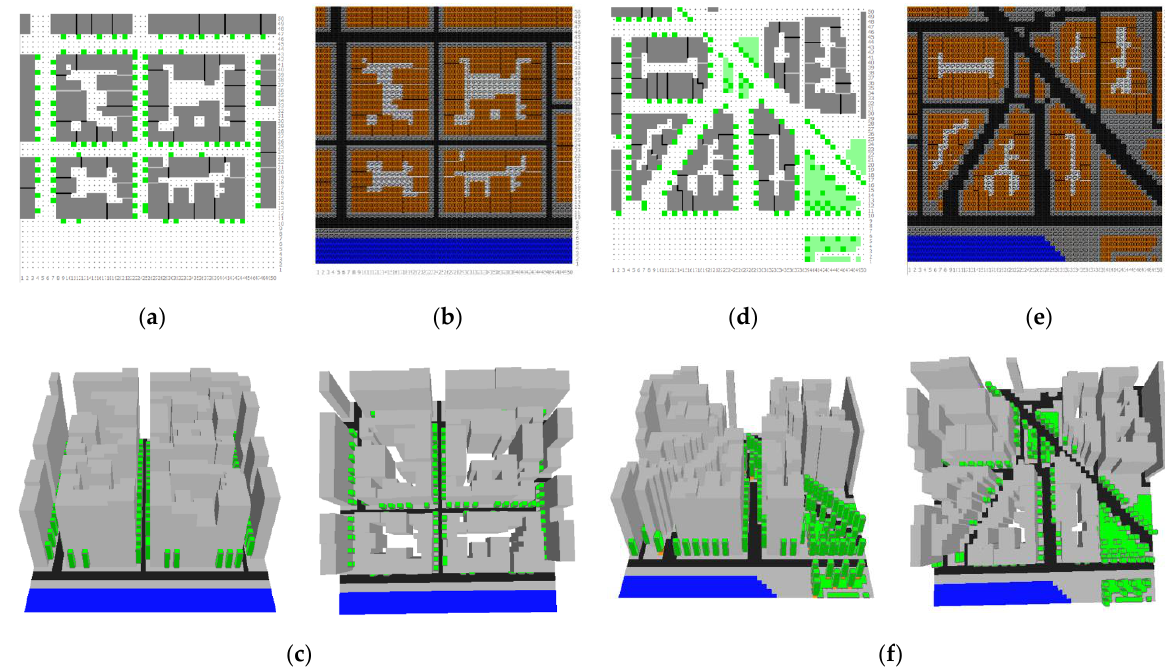
Figure 9. ( a ) Two-dimensional display of the first section where the buildings are shown in gray and the positions of the tree planting in green; ( b ) Two-dimensional display of the first section which shows the surfaces of the model where brown is the clay soil, dark gray is the surface sidewalk, light gray is the uncovered spaces, black is the asphalt, and blue is the sea; ( c ) Three-dimensional display of the first section; ( d ) Two-dimensional display of the second section where the buildings are shown in gray and the positions of the tree planting in green; ( e ) Two-dimensional display of the second section which shows the surfaces of the model where brown is the clay soil, dark gray is the surface sidewalk, light gray is the uncovered spaces, black is the asphalt, and blue is the sea; ( f ) Three-dimensional display of the second section.